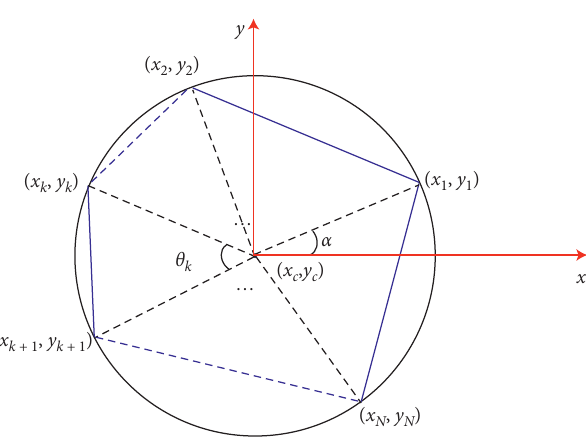
Figure 2: Definition of polygonal particle shape from